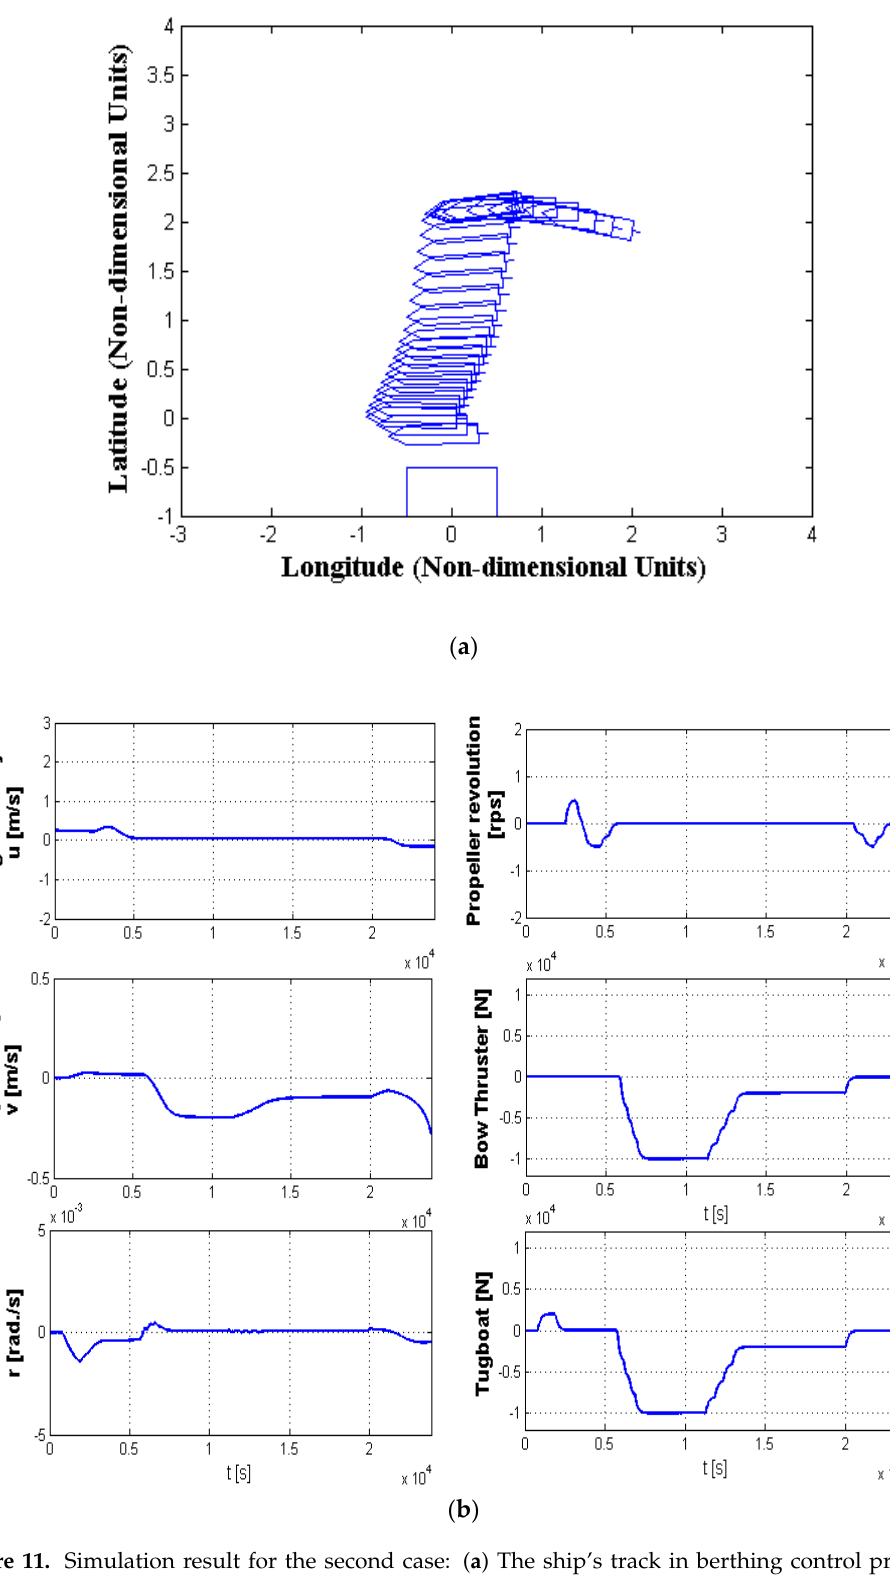
Figure 11. Simulation result for the second case: ( a ) The ship’s track in berthing control process; ( b ) The time history of ship berthing process.